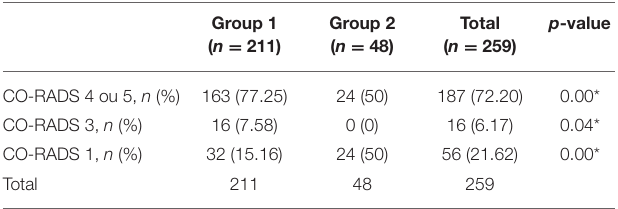
TABLE 4 | CO-RADS of chest CT in symptomatic individuals by group (Belém, PA,